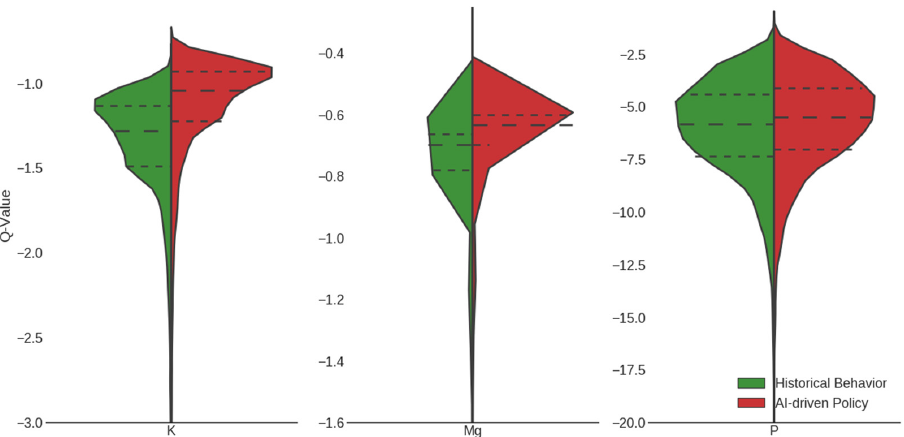
Figure 5. Estimated performance of policy for potassium (K), magnesium (Mg), and phosphate (P) measured by the Q ‐ value prediction, which corresponds to the expected total rewards (time saved, money saved, avoidance of near misses, and side effects) during the entire patient admission. For all three electrolyte policies, the mean Q ‐ value prediction of state–action pairs in the test set was higher for the learned RL policy than for clinician behavior observed in the UPHS data. This suggests that RL optimizes the reward function to create a learned policy that is better than clinician behavior.